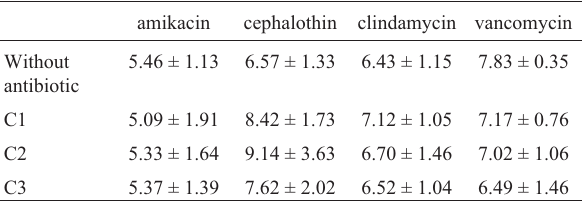
Table 1 - Effect of in vitro administration of amikacin, cephalothin, clindamycin and vancomycin on number of